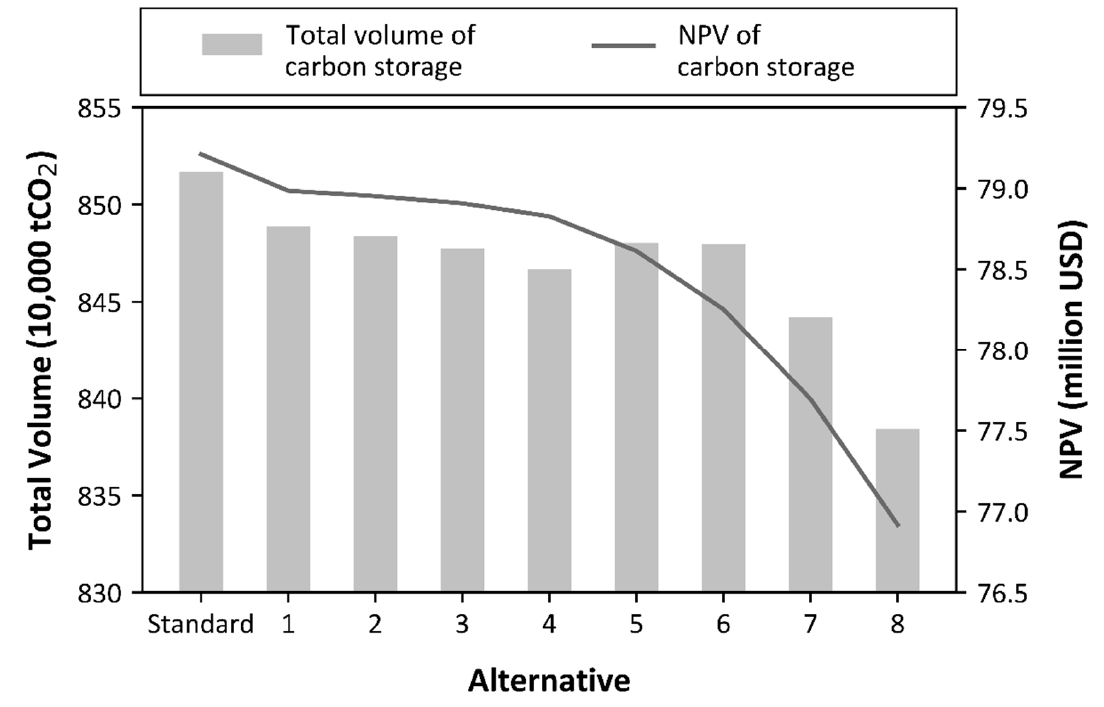
Figure 7. Total volume and NPV of carbon stored during the entire planning horizon for each management alternative.